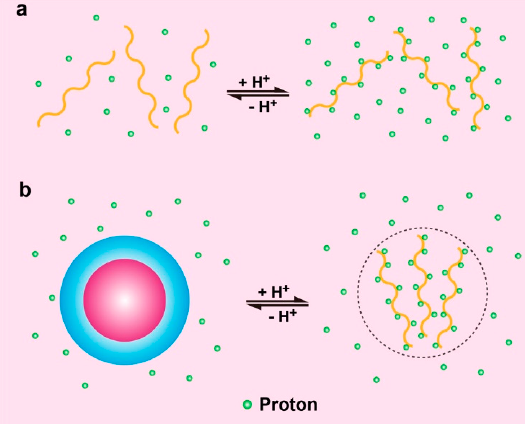
Figure 11. Schematic illustration of phase separation induced cooperativity in pH-triggered supramolecular self-assembly. ( a ) Hydrophilic polymers with ionizable amines were protonated homogeneously, showing no cooperativity. ( b ) Hydrophobic phase separation (e.g., micellization) drove cooperative protonation of amphiphilic pH-responsive polymers. Phase separation also drove the pKa values of polymers to lower pH because of hydrophobic barrier, which required higher proton concentration (lower pH) to initiate the protonation process. Reproduced with permission from Yang Li, Tian Zhao, Chensu Wang, Zhiqiang Lin, Gang Huang, Baran D. Sumer, and Jinming